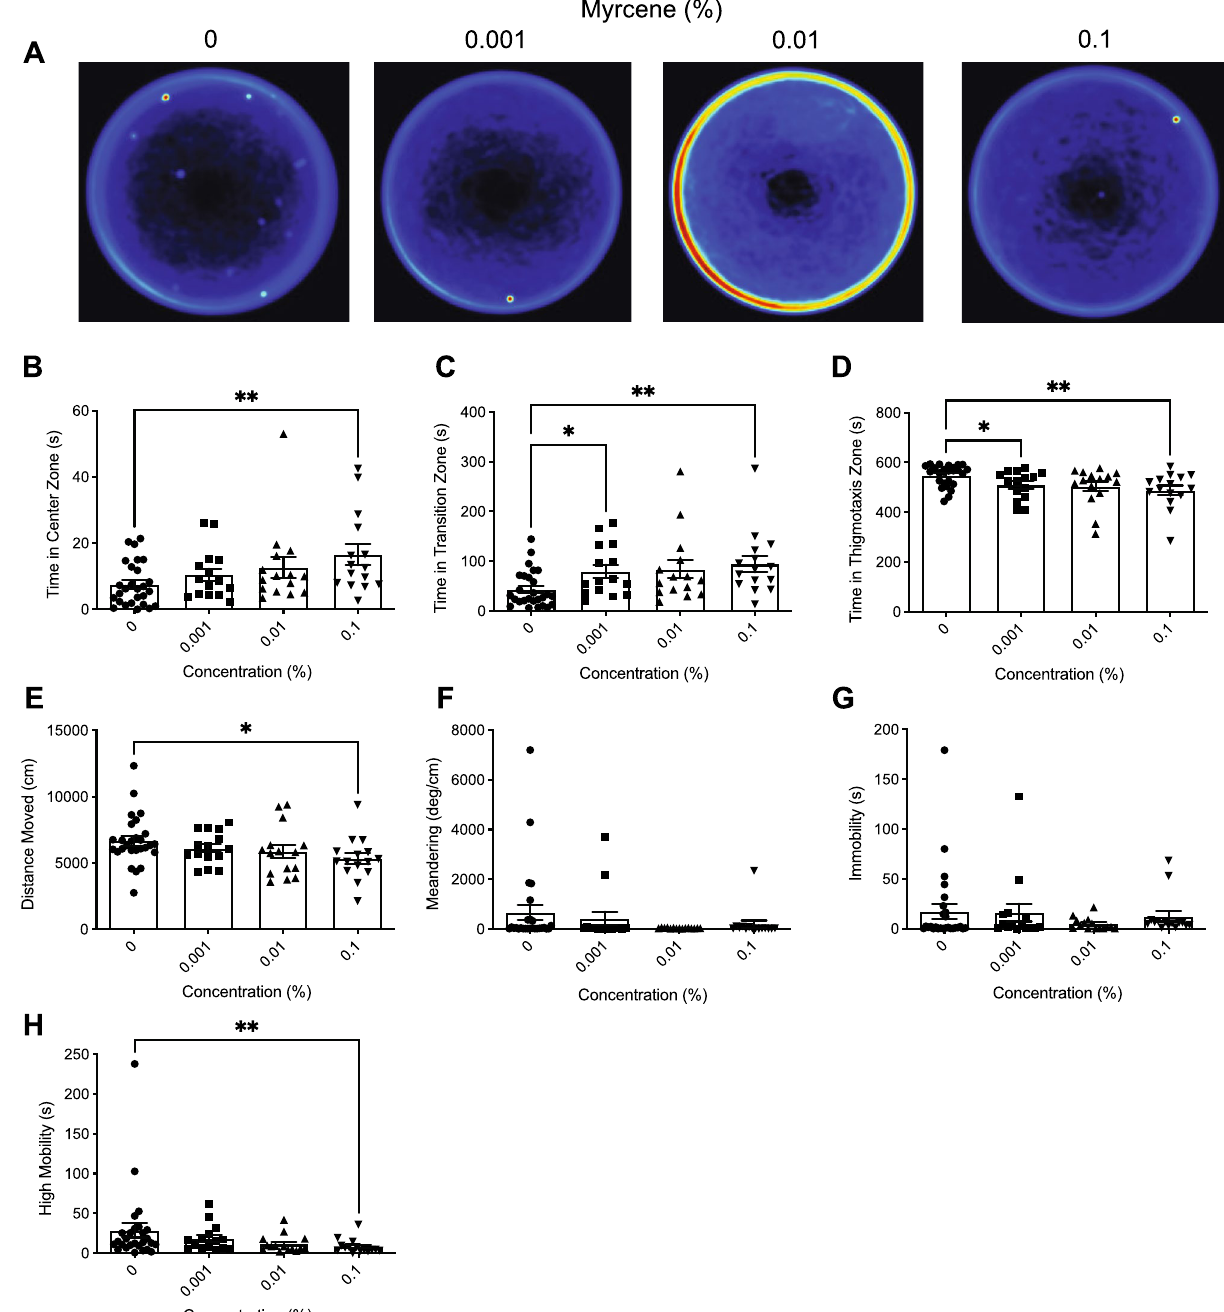
Figure 3. The effects of acute β-myrcene administration on zebrafish behaviour assessed by the open field test. ( A ) Group heatmaps showing a coloured representation of the combined mean location of each group of fish across all trials. Average time spent in the center ( B ), transition ( C ), and thigmotaxis ( D ) zone during the open field test. Fish locomotion was quantified in the open field test by measuring distance moved ( E ), meandering ( F ), time spent immobile ( G ), and time spent highly mobile ( H ). All data are presented as mean ± S.E.M. Significant differences between controls and β-myrcene treated groups are indicated by *( P < 0.05) and **( P <